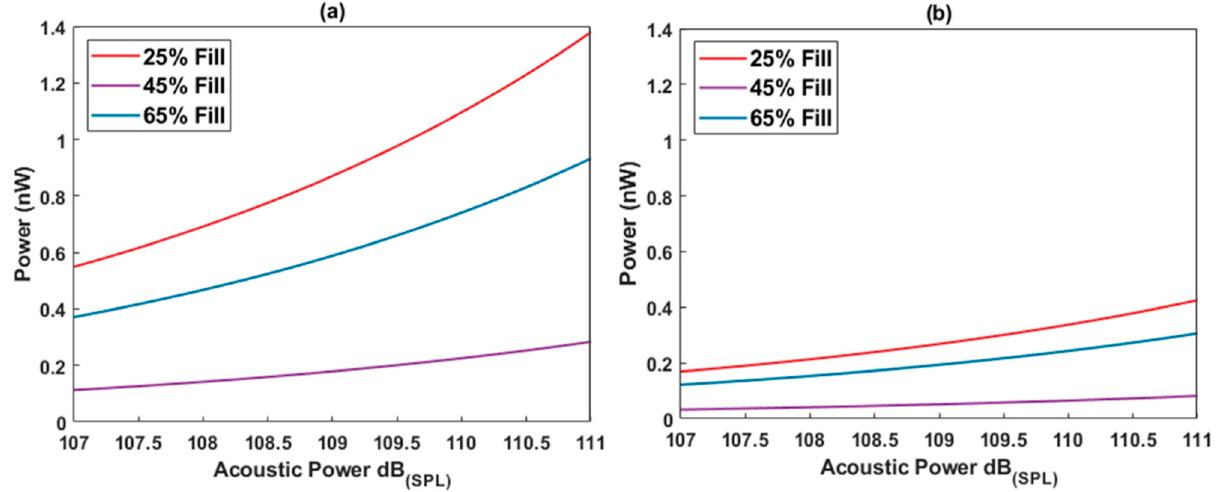
Figure 5. Power generation as a function of the sound pressure level for ( a ) an open boundary condition and ( b ) a shorted boundary condition.